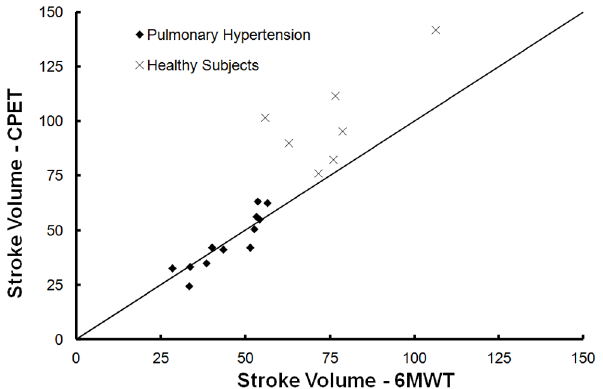
Figure 5. Stroke volume calculated directly after the end of a 6MWT and of a CPET in 12 pulmonary hypertension patients and 7 healthy subjects. (-) Line of identity (where SV 6MWT =SV CPET ). doi:10.1371/journal.pone.0092324.g005 Seven healthy subjects performed the 6MWT with a cardio-